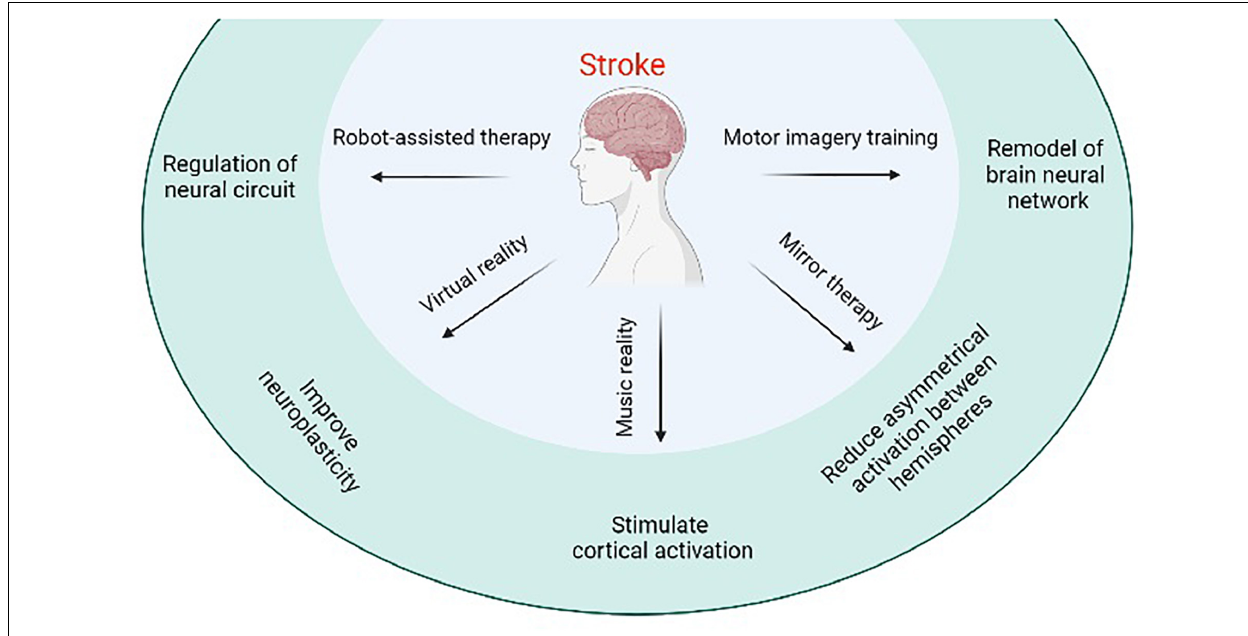
FIGURE 1 | Schematic illustration of emerging the modern rehabilitation